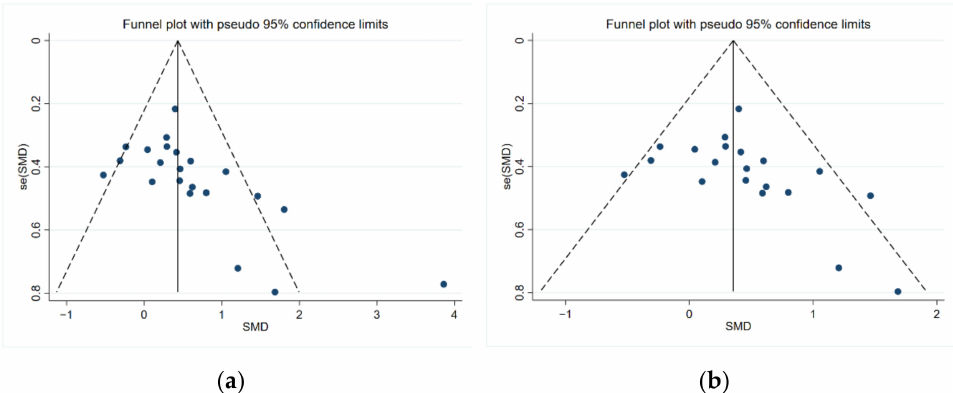
Figure 3. ( a ) Funnel plot of all included studies; ( b ) funnel plot after outlier